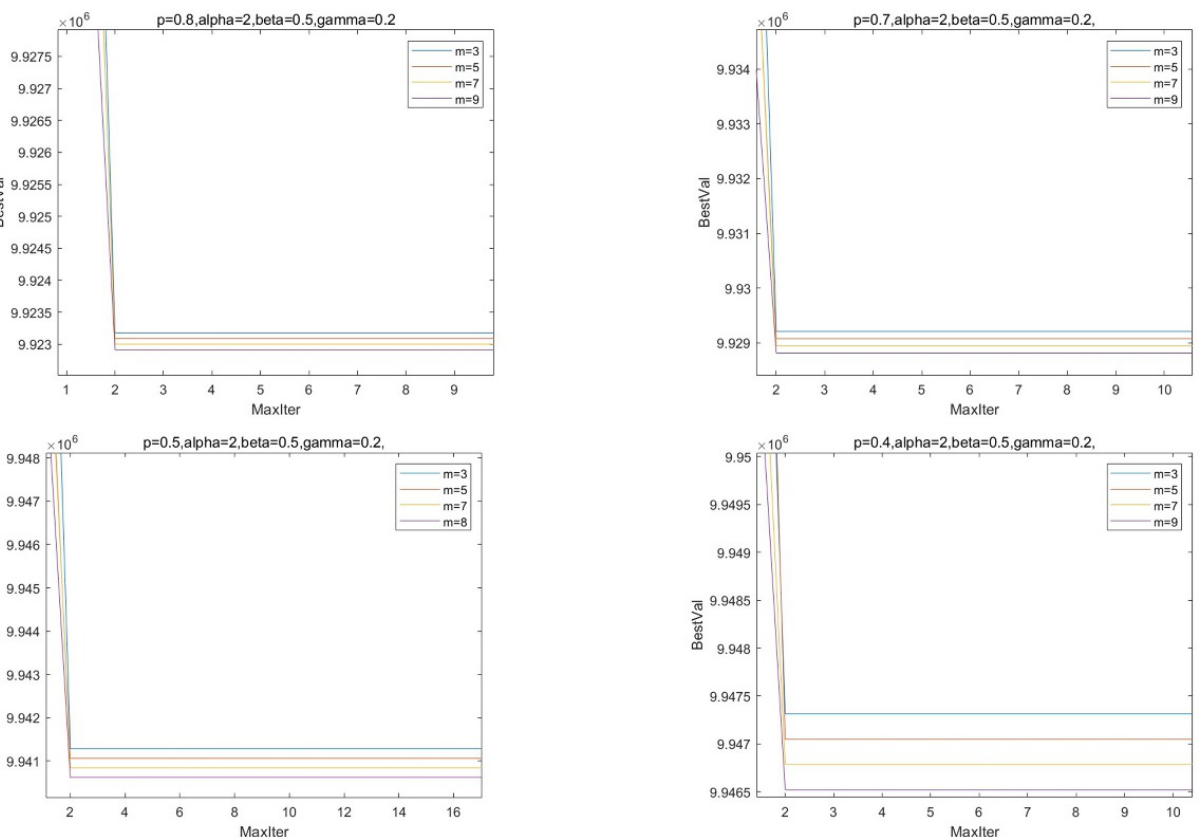
Fig. 5 Relationship map between defender loss and rational degree change of attacker and site selection facilities of m=3-8